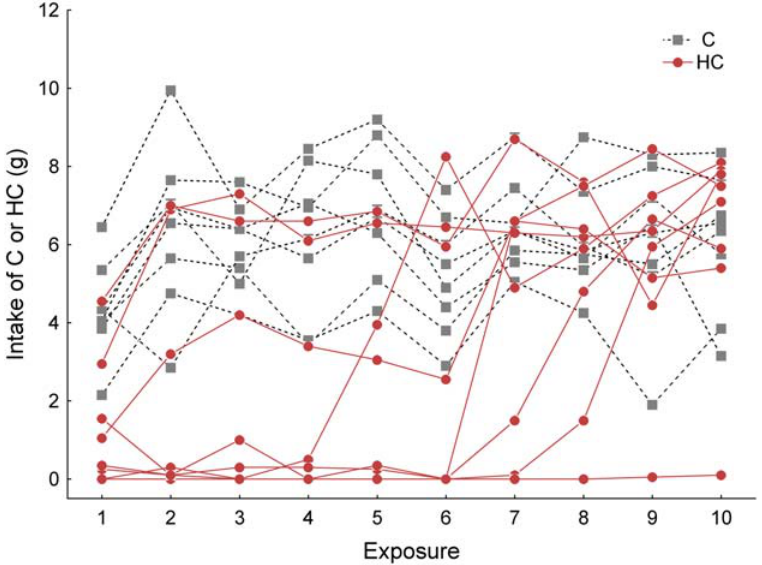
Figure 7. Individual guinea pig intake of either HC or C diets during exposure sessions. Rose circles and continuous lines depict individuals exposed to HC during a 4–5.5 h period in which the HC diet was the only food available; C-exposed animals are depicted with grey squares and dashed lines.